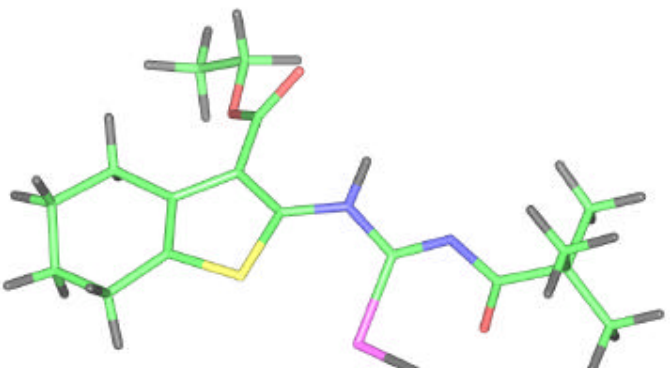
Figure 7. Molecular design of 8 according to the computational calculation.